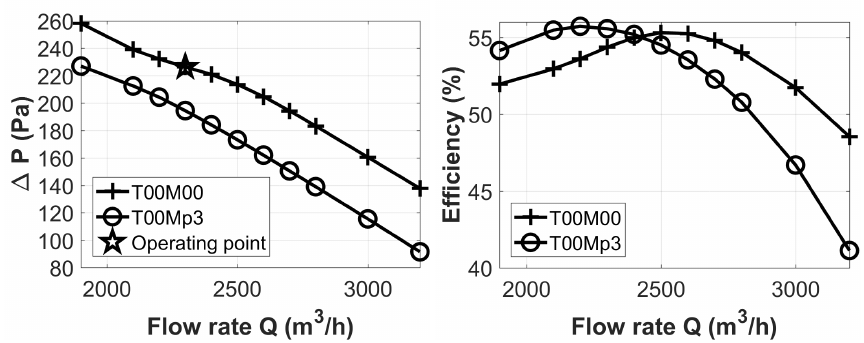
Figure 5. Reference fan characteristic curves: ∆ p -Q and η -Q. T00M00 and T00Mp3 represent two different geometric configurations. The stagger angle at mid-span of T00Mp3 is 3 ◦ more than that of T00M00 (Reference configuration).